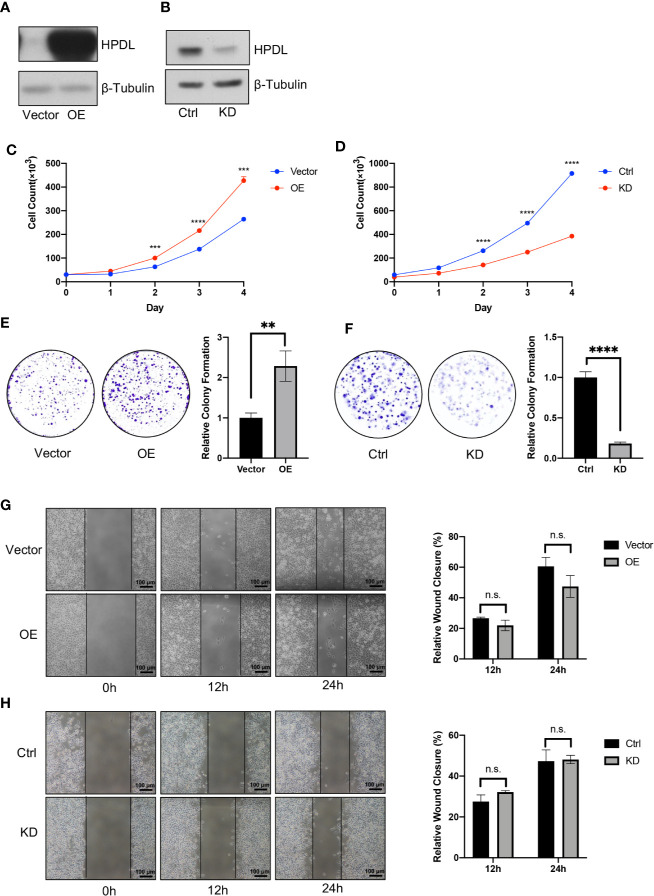
HPDL promotes pancreatic ductal adenocarcinoma in vitro. (A, B) Validation of HPDL overexpression (A) and knockdown (B) cells with theirs paired control cells. HPDL overexpression (OE) model and its empty vector control (Vector) were generated in PaTu 8988t, HPDL knockdown (KD) model and its scramble control (Ctrl) were generated in MIA PaCa-2. Cell lysate was separated with SDS-PAGE and immunoblotted with antibodies as indicated. β-Tubulin was used as loading control. (C, D) Cell proliferation of HPDL OE (C) and KD (D) cells with theirs paired control cells. Cells were seeded in 12-well plate and counted for 4 days. (E, F) Colony formation analysis of HPDL OE (E) and KD (F) cells with theirs paired control cells. Cells were seeded in 6-well plate and stained with crystal violet after 10-day culture. (G, H) Wound healing analysis of HPDL OE (G) and KD (H) cells with theirs paired control cells. Cells were seeded in 6-well plate and scratched with a pipette tip. Wound closure was measured at 0, 12, and 24 h. (**P < 0.01. ***P < 0.001. ****P<0.0001. n.s., no significance.)